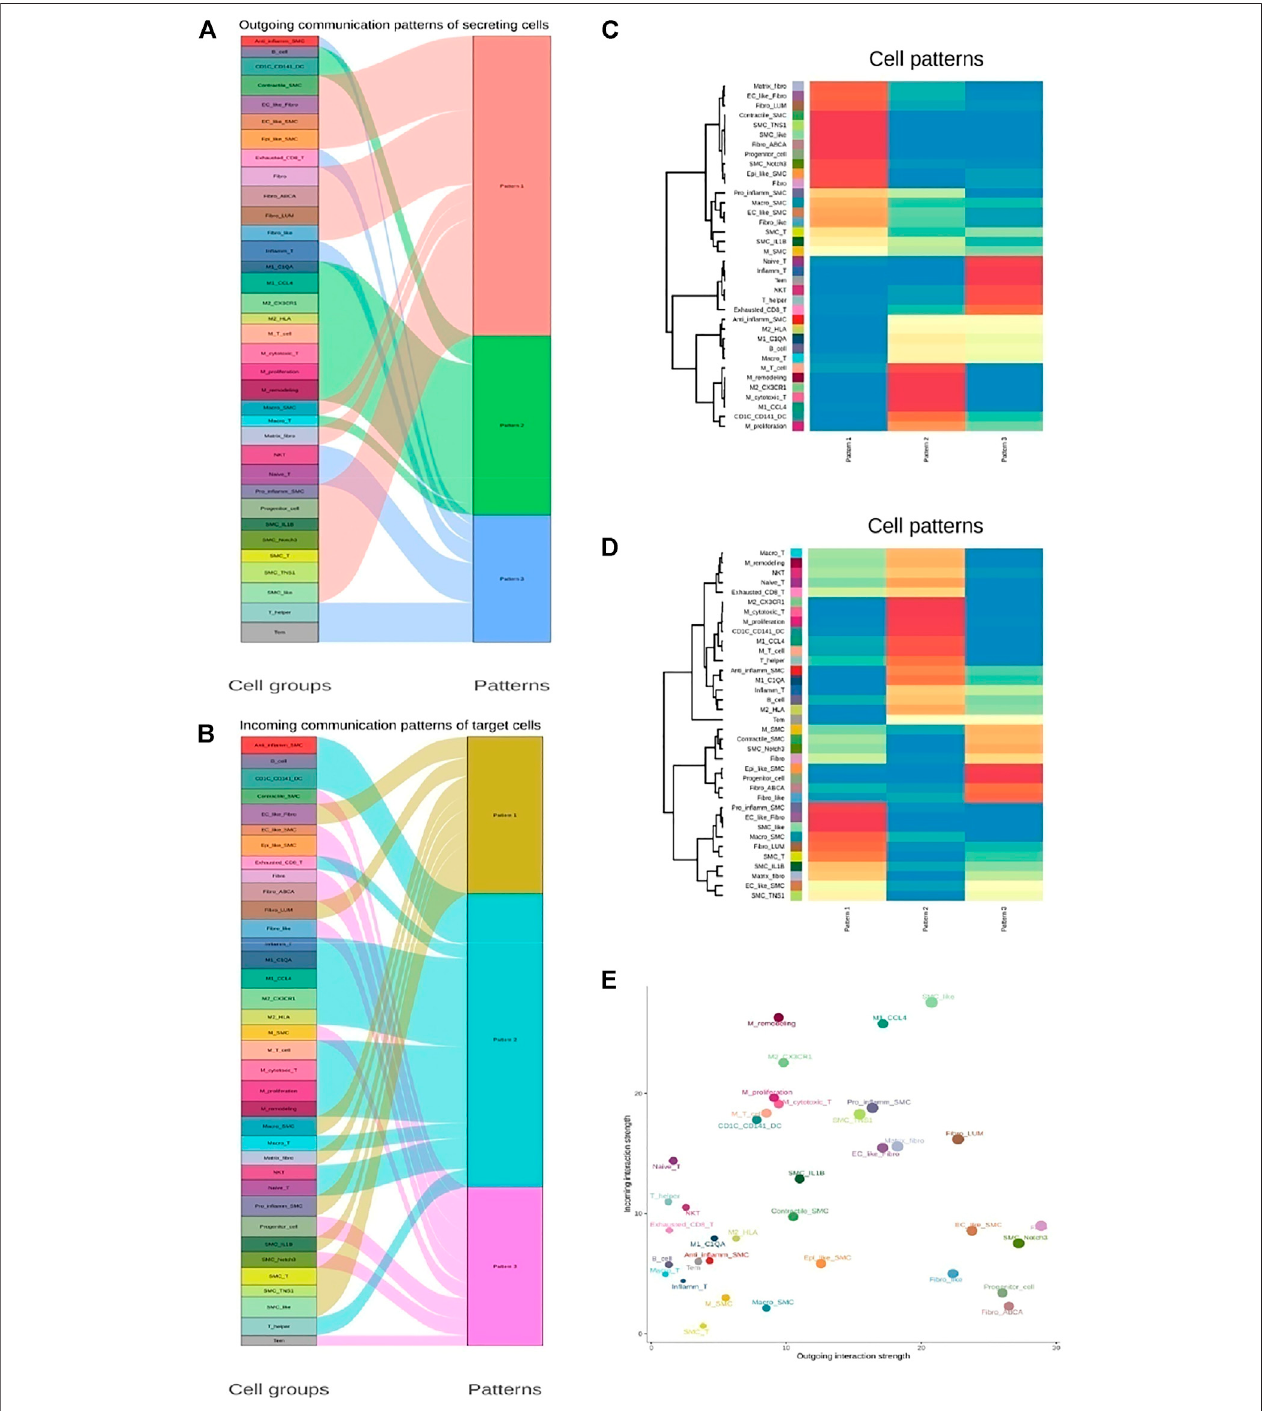
FIGURE 7 | The key communications among four types of cell subpopulation. (A) River map showing the outgoing communication patterns of target cells by the key signals for subpopulations among T, SMC, fi broblast, and Mo-Mac cells. (B) River map showing the incoming communication patterns of target cells by the key signalsforsubpopulationsamongT,SMC, fi broblast,andMo-Maccells. (C) Heatmapshowingtheoutgoingthreecommunicationpatternscalculatedbythekeysignals forsubpopulationsoftargetcells. (D) Heatmapshowingtheincomingthreecommunicationpatternscalculatedbythekeysignalsforsubpopulationsoftargetcells. (E) Comparison of total incoming path weights with total outgoing path weights among T, SMC, fi broblast, and Mo-Mac cell populations. (F) Heatmap showing the key ligands in the outgoing signaling pattern of a subpopulation as secreting cells. (G) Heatmap showing the key receptors in the incoming signaling pattern of a subpopulation as receiver cells. (H – K) Hierarchical network diagram of important cell-cell communication modes between Tcell_vs._Mo-Mac (H) , SMC_vs._Fibroblast (I) , Fibroblast_vs._SMC (J) and Mo-Mac_vs._SMC (K) . Edge thickness represents the sum of key signals of weight between subgroups.